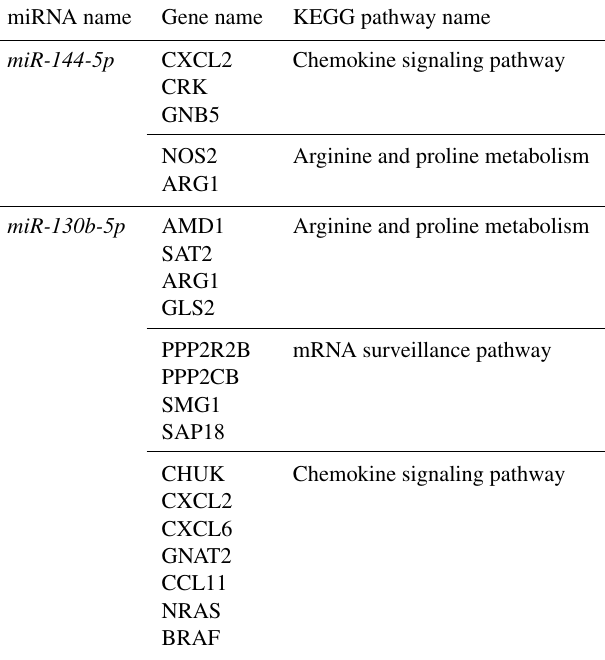
Table 2. Target genes of miR-144-5p and miR-130b-5p